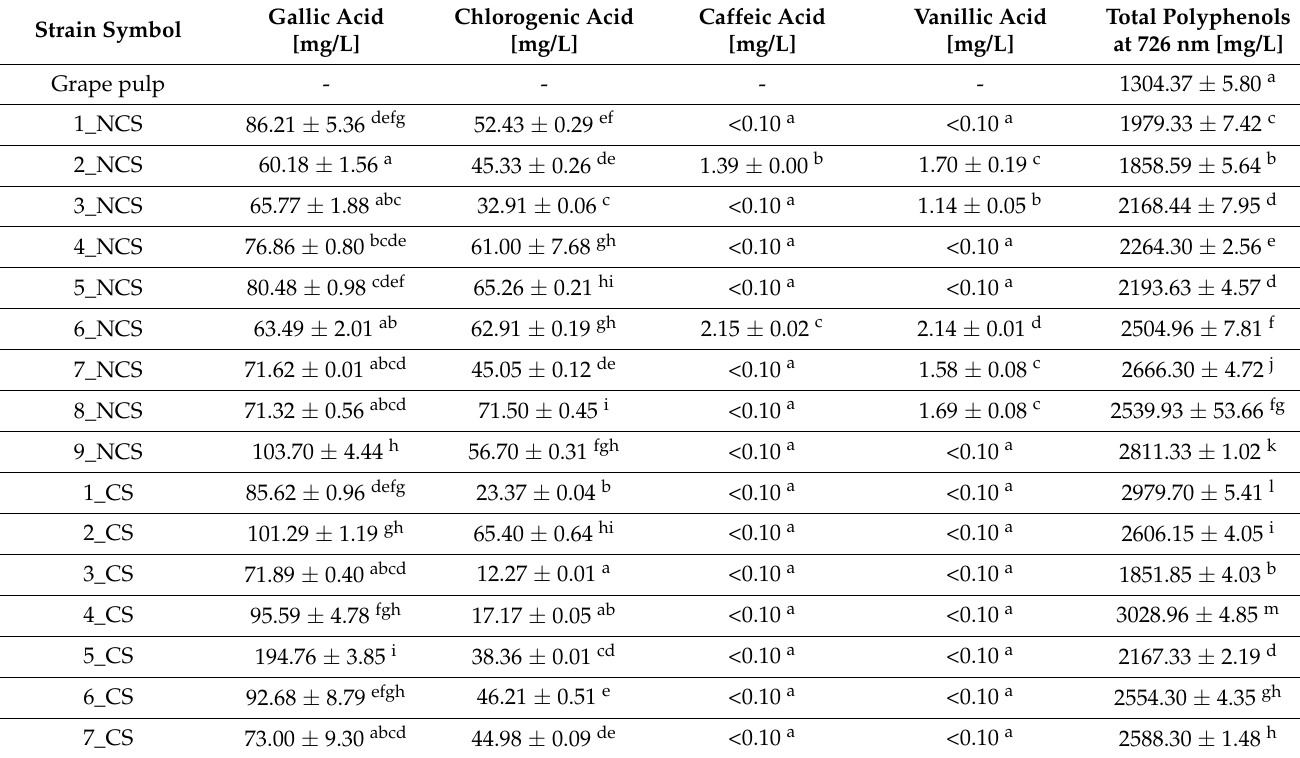
Table 4. Analysis of polyphenolic compounds in red